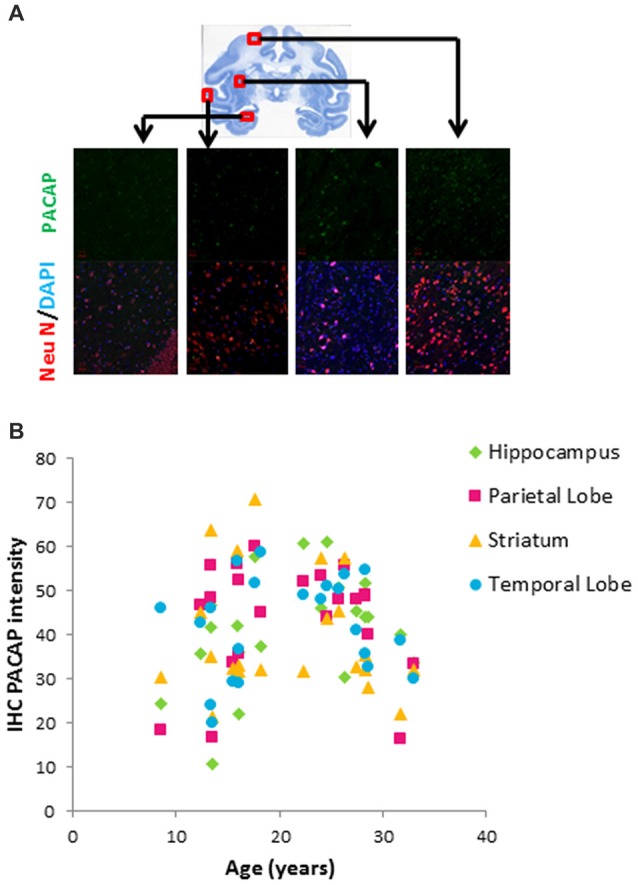
Age-related changes in pituitary adenylate cyclase activating polypeptide (PACAP) in different brain areas of rhesus macaques. (A) Immunohistochemistry (IHC) of PACAP. Double staining of NeuN (red) and DAPI (blue) depicted neurons. Immunostaining intensity of PACAP (green) was assessed within the randomly selected 10 neurons in each visual field. At least three visual fields were assessed for each slide and averaged to calculate IHC intensity of PACAP for each individual animal. PACAP intensity from each region (hippocampus, parietal lobe, striatum and temporal lobe) was plotted against age. (B) Biphasic pattern of PACAP across the life span.